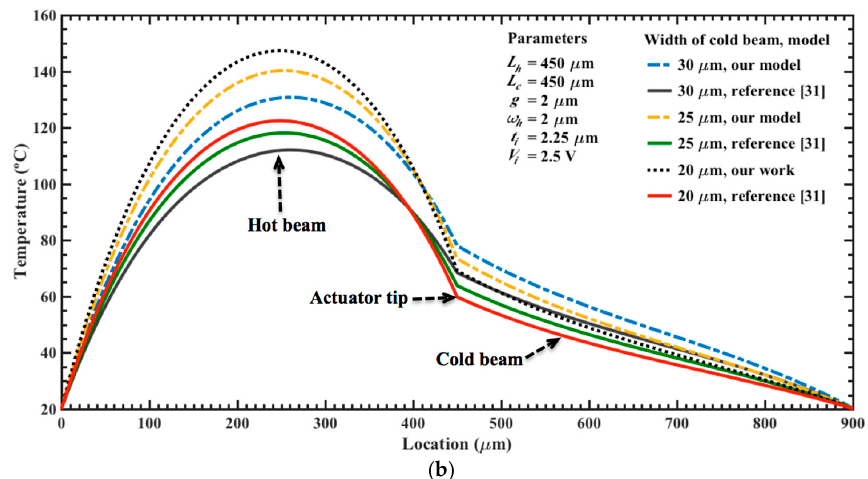
Figure 9. Distribution of the temperature along of the upper (hot) and bottom (cold) beams of an electrothermal actuator, modifying the width of the ( a ) upper and ( b ) bottom beams. For both cases, the length of the actuator is 450 μ m and bias voltage is 2.5 V, respectively. Micromachines 2017 , 8, x FOR PEER REVIEW